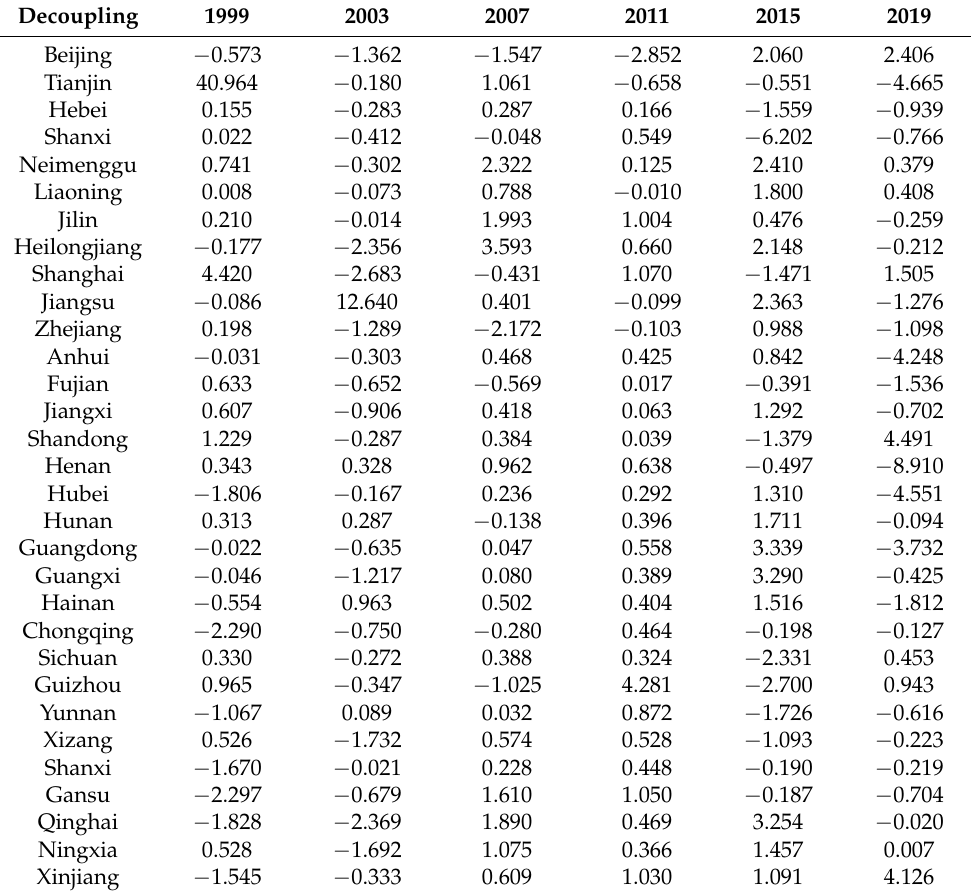
Table 5. The decoupling relationships from 1998 to